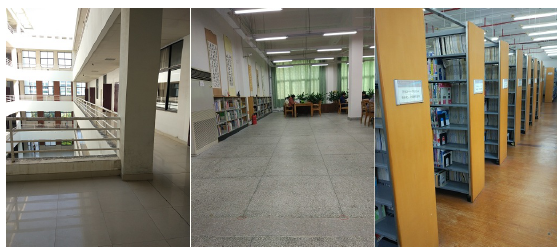
Figure 3. Different scenarios.